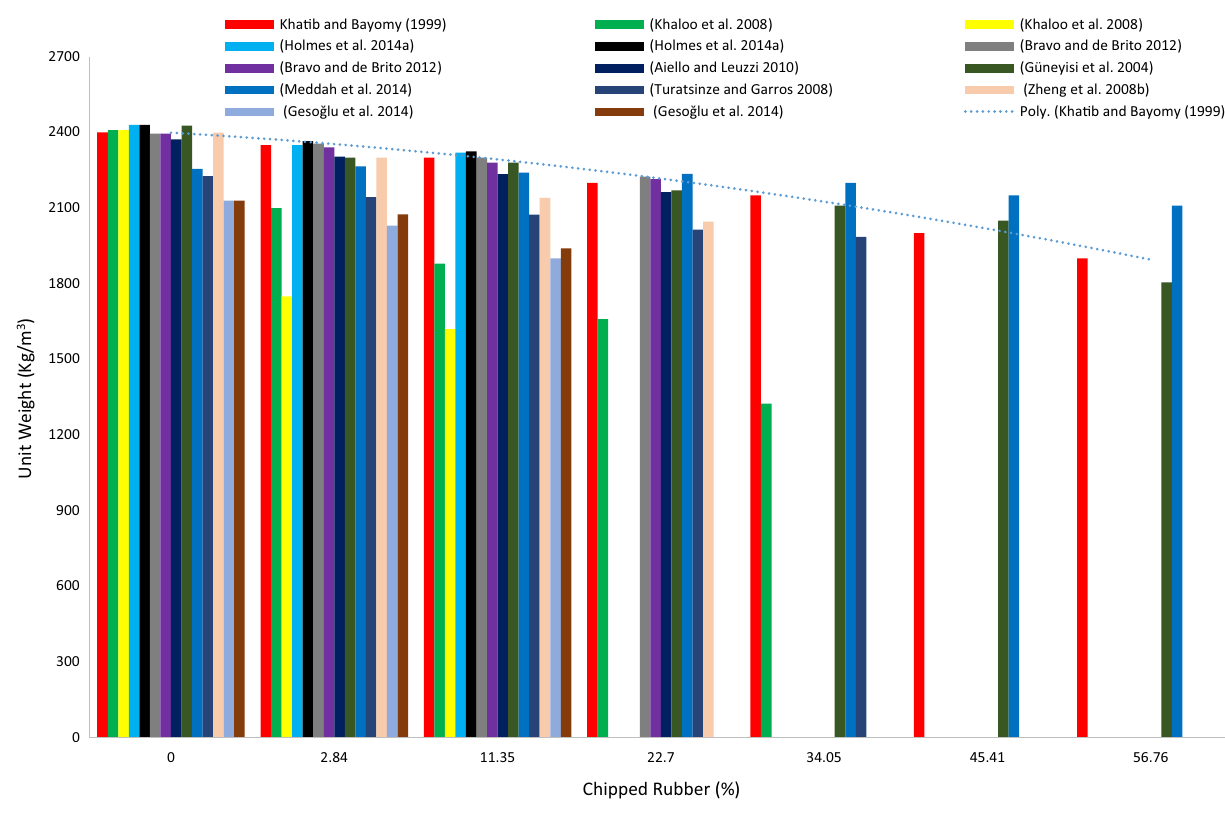
Fig. 7 Unit weight of chipped rubbercrete [8, 20, 25, 28, 32, 35, 56,